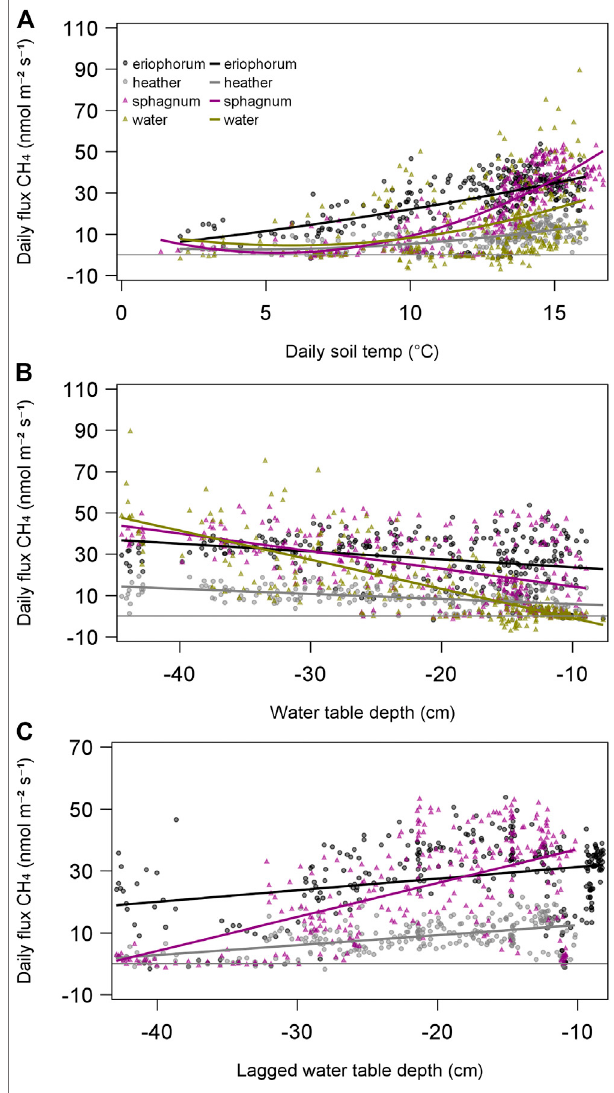
FIGURE 8 | Effect of soil temperature (A) and water table (B) on daily meanCH 4 fl ux from each ecotype. HysteresisofCH 4 fl uxresponsetowateris illustrated by the negative relationship of fl uxes to concurrent measurements of water table depth. A delayed response is apparent when fl uxes are regressedagainstalaggedrunningaverageofwatertabledepth(exceptinthe open water ecotype), with the lag varying between 84 days (eriophorum) and 86 days (sphagnum) (C) .